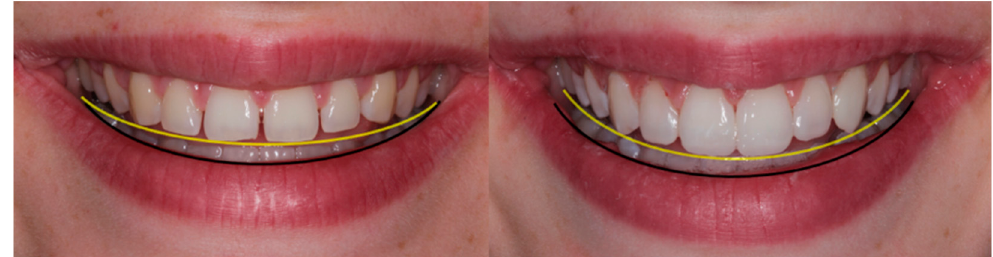
Figure 5. Case 2 smile designing considering incisal edge parallelism to lower lip contour.